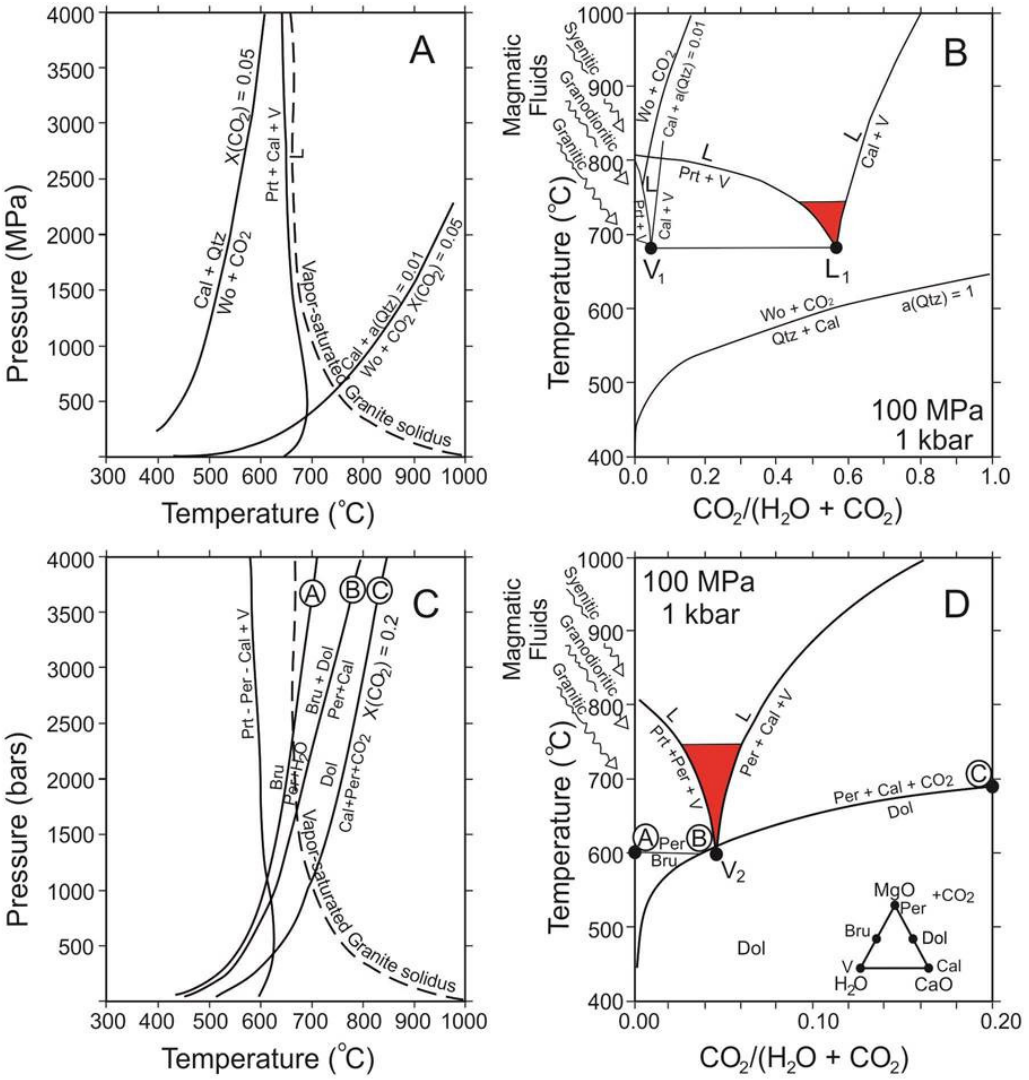
Figure 15. ( A , C ) Pressure vs. temperature diagram; ( B , D ) temperature vs. X(CO 2 ) diagram for CaO-CO 2 -H 2 O ( A , B ) and MgO-CaO-CO 2 -H 2 O ( C , D ) systems, after [55]. Panels ( A , B ) illustrate calcite + quartz → wollastonite + CO 2 decarbonation reaction (at an X (CO2) = 0.05 in ( A ) and a quartz activity (a(Qtz)) of 1 and 0.01 (in solution) relative to portlandite-calcite-vapor-liquid (melt) eutectic (CaO-CO 2 -H 2 O system [46], and the vapor-saturated granite solidus. Cal = calcite, Prt = portlandite, Qtz = quartz, V = vapor (fluid), and L = liquid (melt). Panels ( C , D ) illustrate decarbonation reaction dolomite → periclase (or brucite) + calcite + CO 2 (at a X (CO2) = 0.05 in ( A ) relative to portlandite-calcite-periclase-vapor-liquid (melt) eutectic (MgO-CaO-CO 2 -H 2 O system [47], and the vapor-saturated granite solidus. Dol = dolomite, Per = periclase, Bru = brucite, Cal = calcite, Prt = portlandite, V = vapor (fluid), and L = liquid (melt). Red region corresponds to crustal conditions in which melting is possible.